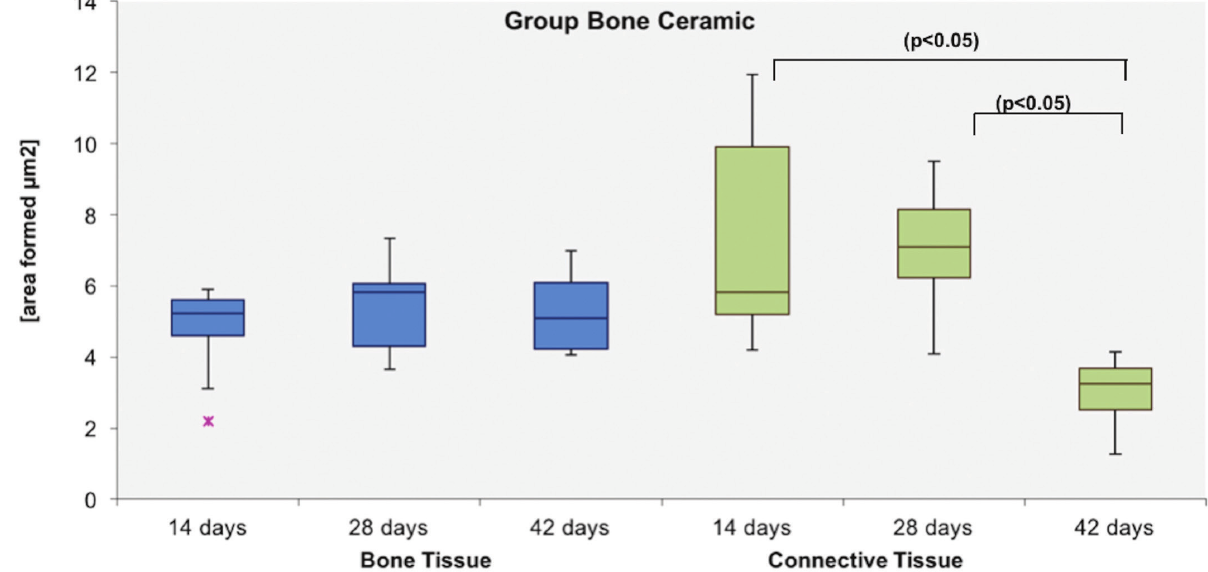
Figure 3- Graphic box-plot showing BCG. Bone and connective tissue at 14, 28 and 42